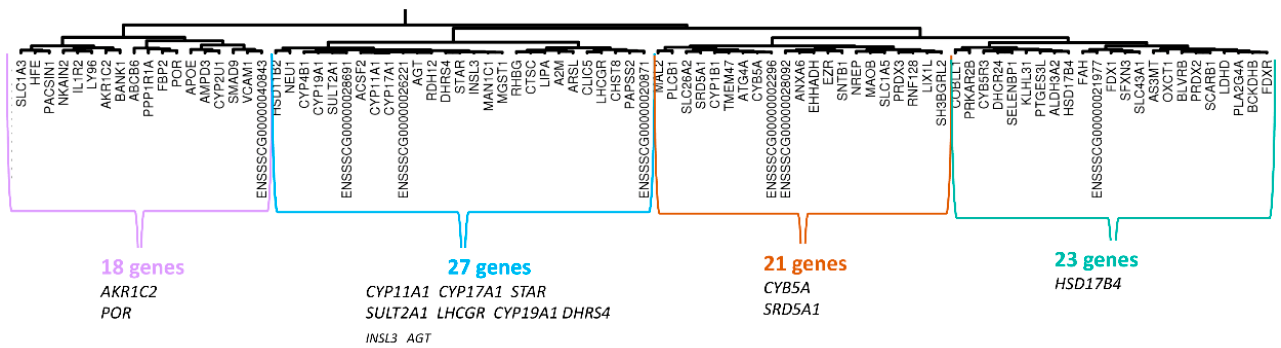
Figure 4. Presentation of CYP11A1-cluster-PLW89. An HCA was built with data (mRNAseq-PLW) observed for the 469 genes included in the correlation module previously defined by WGCNA analysis around CYP11A1 . The analysis of this clustering allowed the selection of a group of 307 genes linked by correlations. In this figure, only the sub-cluster (89 genes) including CYP11A1 is shown. For the composition of sub-clusters, we have prioritized genes present in the group around CYP11A1 characterized by RT-qPCR (see Figure 1).